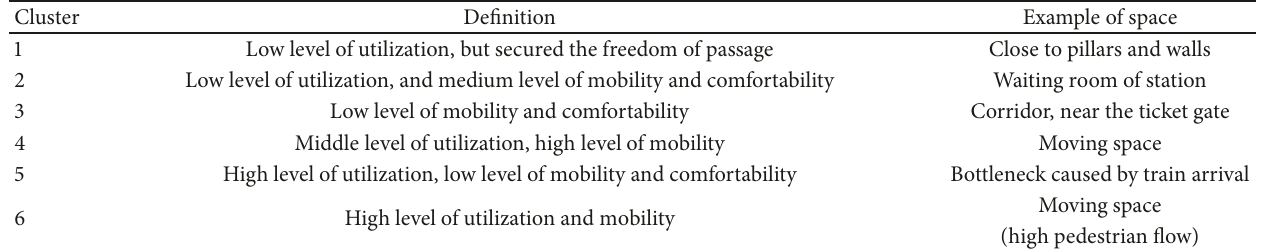
Table 3: Definition of the indoor space at Samseong station based on clustering